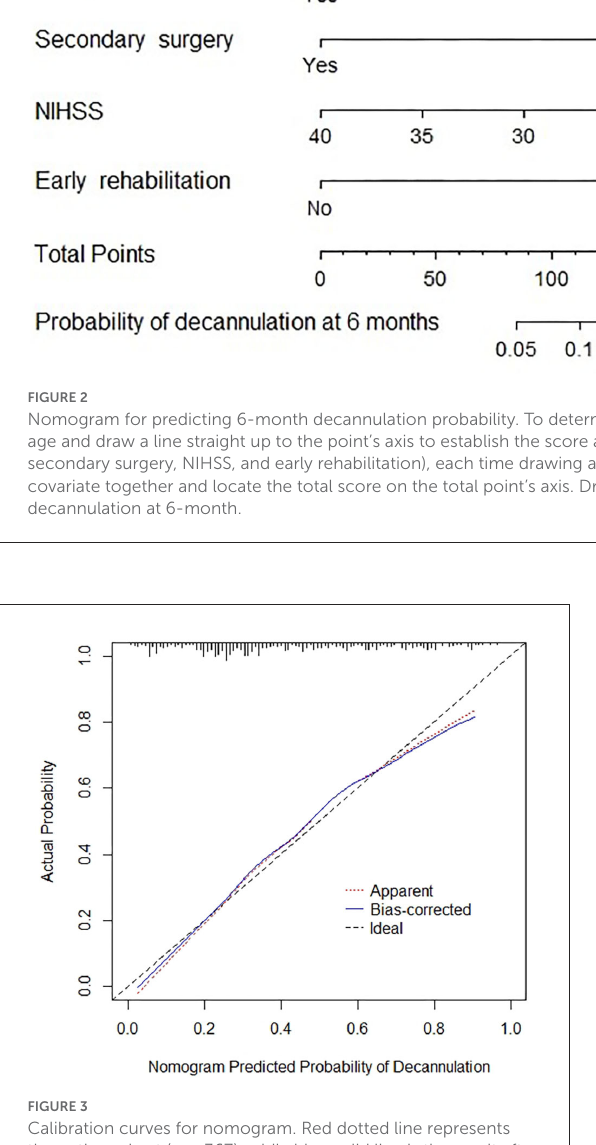
score. In our study, GCS was associated with the probability of decannulation in univariate analyses but not in multivariate analyses. Clinicians usually use GCS to evaluate nervous system